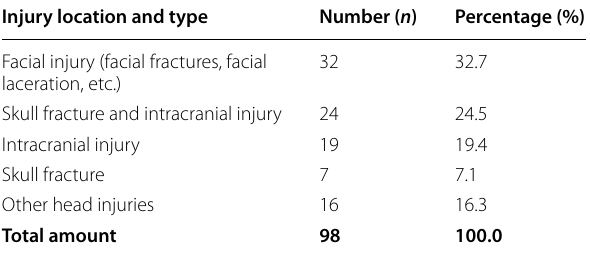
Table 1 Types of incidents that caused the injury Incidents Number ( n ) Percentage (%) Non-traffic accidents (pedestrian, etc.)